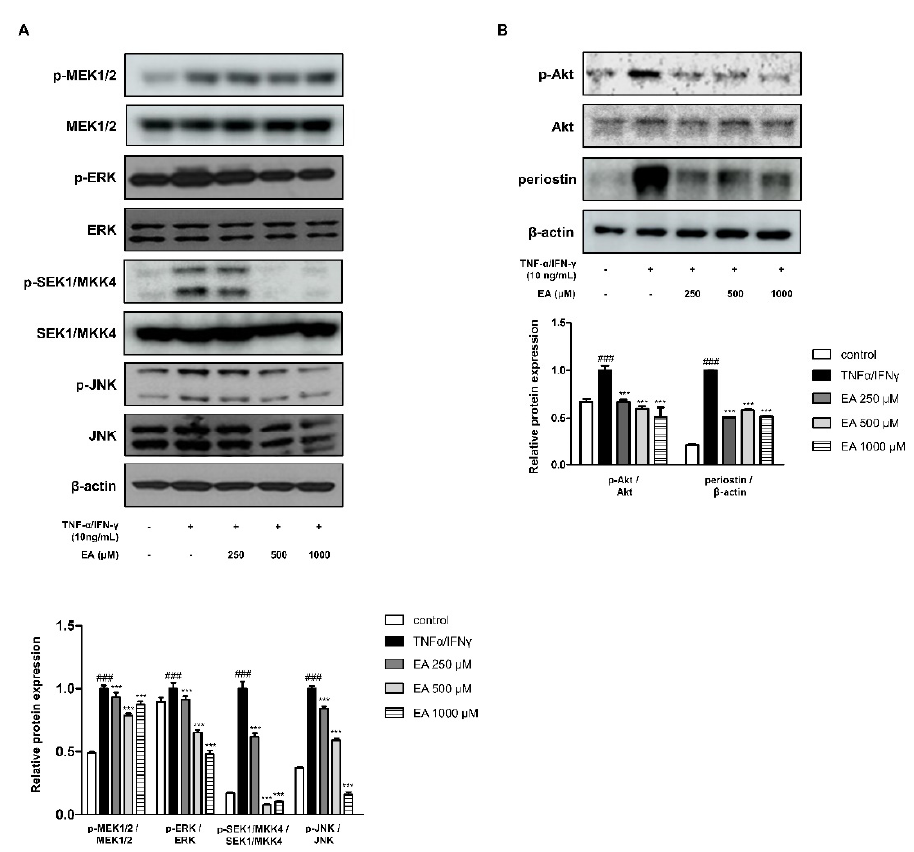
Figure 2. Effects of EA on mitogen-activated protein kinase (MAPK)-related signaling pathways in HaCaT keratinocytes. Cells were treated with 250, 500, or 1000 µ M of EA for 1 h prior to the addition of TNF- α /IFN- γ and incubated for 10–20 min. Phosphorylation of ( A ) MEK1/2-ERK and SEK1/MKK4-JNK cascades was assayed by western blot analysis. The graph shows the ratio of phosphorylated MEK1/2-ERK and SEK1/MKK4-JNK to total MEK1/2-ERK and SEK1/MKK4-JNK, respectively. ( B ) Phosphorylation of Akt and periostin was analyzed by western blot assay. The ratios of p-Akt to Akt and periostin to β -actin are presented. Values represent the mean ± standard error mean (SEM) of triplicate independent experiments ( n = 3). *** p < 0.001 versus the only TNF- α /IFN- γ -treated group, ### p < 0.001 versus the control group by ANOVA and Dunnett’s post-hoc test.